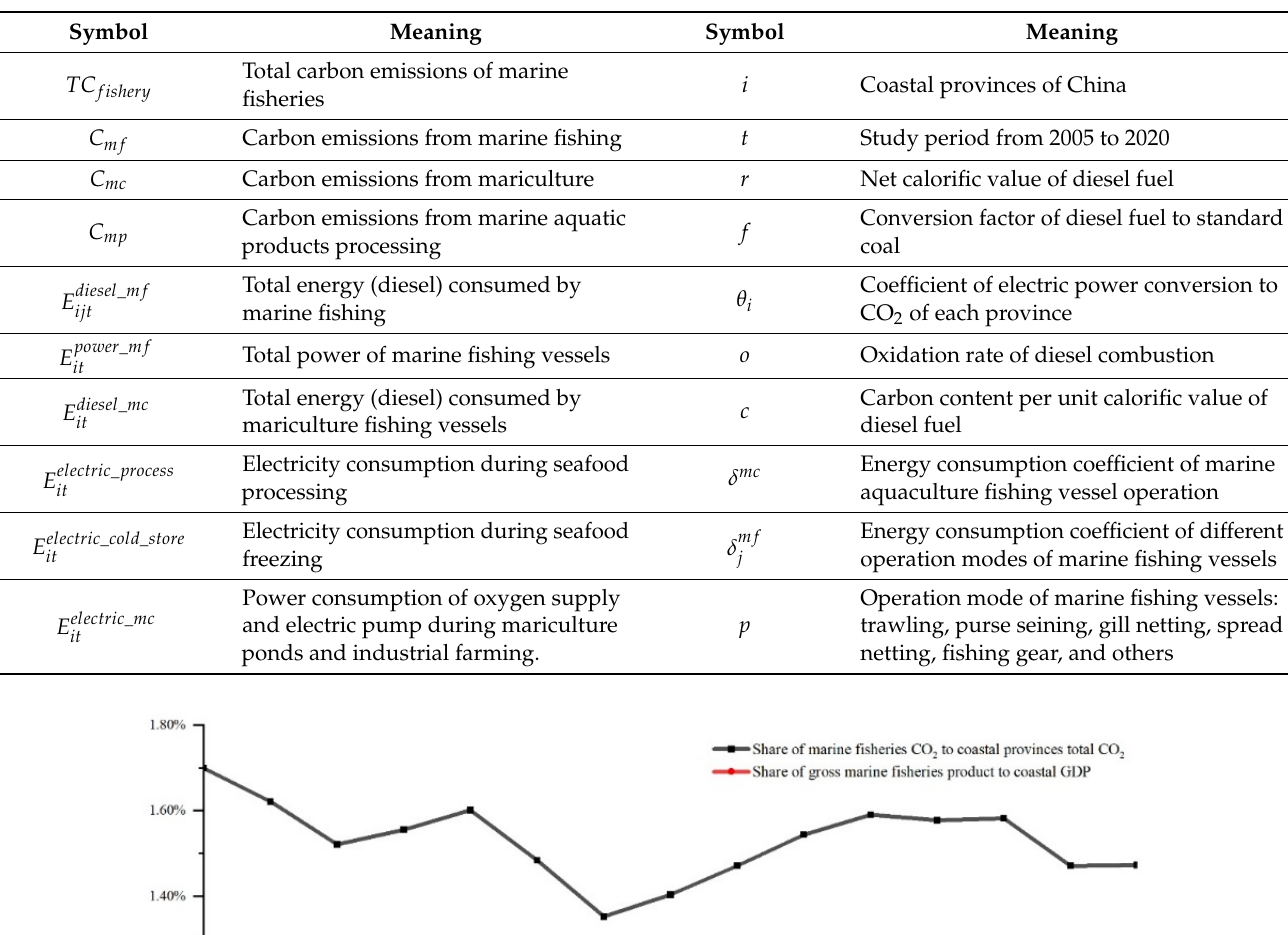
Table 1. The meaning of the symbols in the formula.